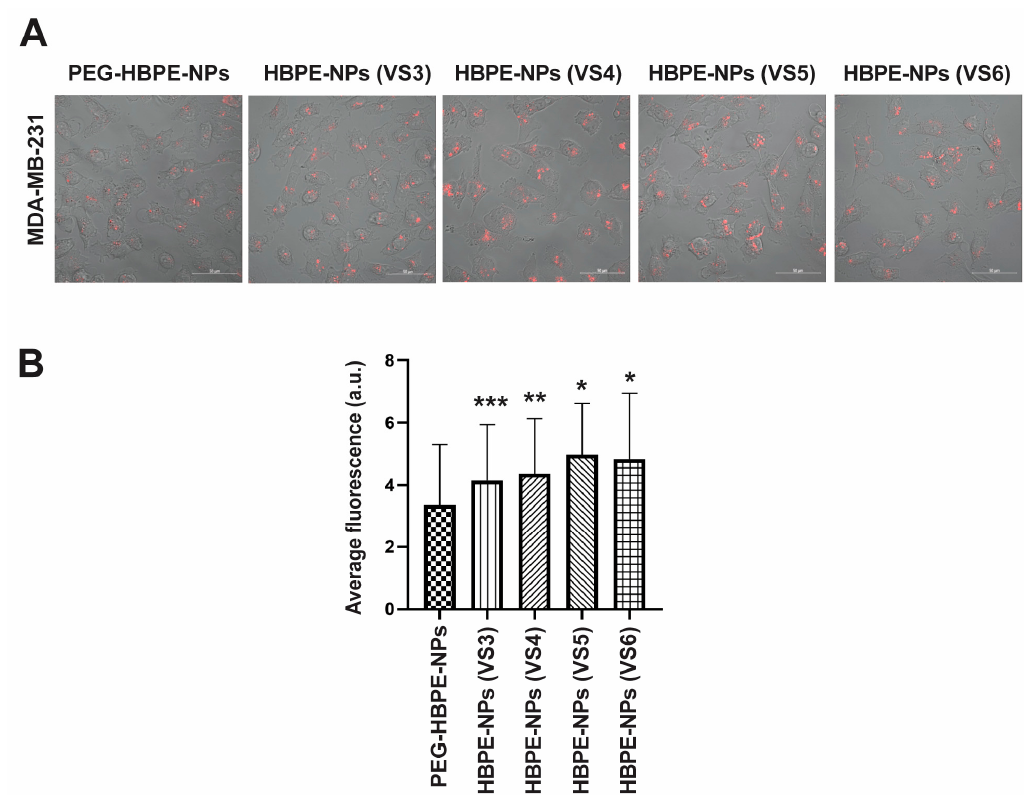
Figure 4. HBPE-NPs pre-treated with sera from IAV-infected mice are taken up by breast cancer cells after interaction with an endothelial layer. ( A ) Transwell experiment in which HUVECs (top chamber) were treated with DiI-loaded HBPE-NPs, and uptake was assessed by MDA-MB-231 cells (bottom chamber). Representative confocal microscopic images of MDA-MB-231 cells are shown after 24 h treatment of HUVECs with PEG-HBPE-NPs, HBPE-NPs (VS3), HBPE-NPs (VS4), HBPE- NPs (VS5), and HBPE-NPs (VS6). The scale bar represents 50 µ m. Images were acquired at 20 × magnification. ( B ) Red fluorescence (DiI nanoparticle presence) quantification bar graphs of bottom chamber MDA-MB-231cells after 24 h post-treatment of top chamber HUVECs with PEG-HBPE-NPs, HBPE-NPs (VS3), HBPE-NPs (VS4), HBPE-NPs (VS5), or HBPE-NPs (VS6). Average DiI fluorescence per cell was used for quantification from images of 100 cells taken by a Cytation 5 Cell Imaging blue software. Data represent mean ± standard deviation. * p -value < 0.0001, ** p -value = 0.0002,